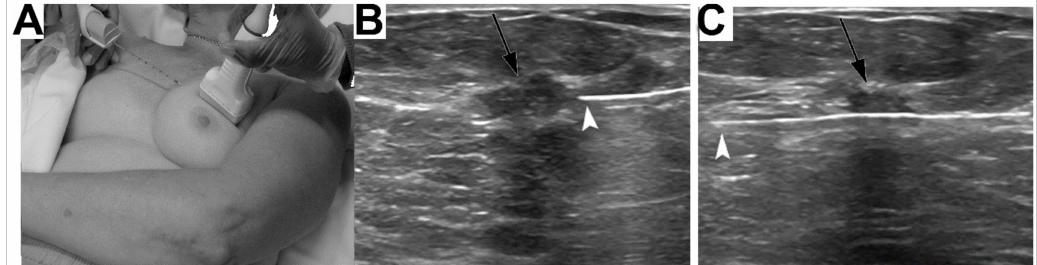
Figure 2. Image of ultrasound placement for ultrasound-guided biopsy. ( A ) Image of ultrasound-guided biopsy for medial breast lesions. ( B ) In the prefire position, needle tip (white arrowhead) should be placed at the margin of most lesions (black arrow), with needle parallel or near parallel to chest wall. ( C ) Postfire images should be documented and should definitively outline the needle traversing the lesion (black arrow). The tip of the needle may lie beyond the lesion margin in some cases, depending on the size of the target (white